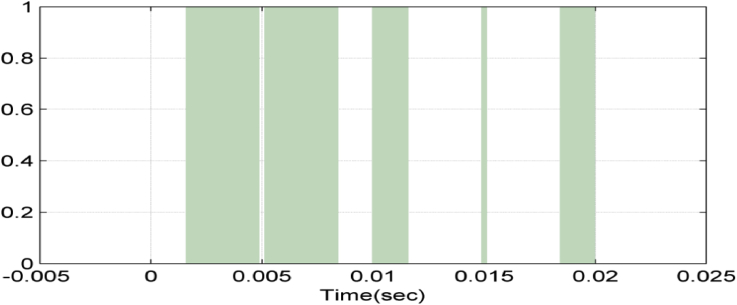
TR1 gate signal.